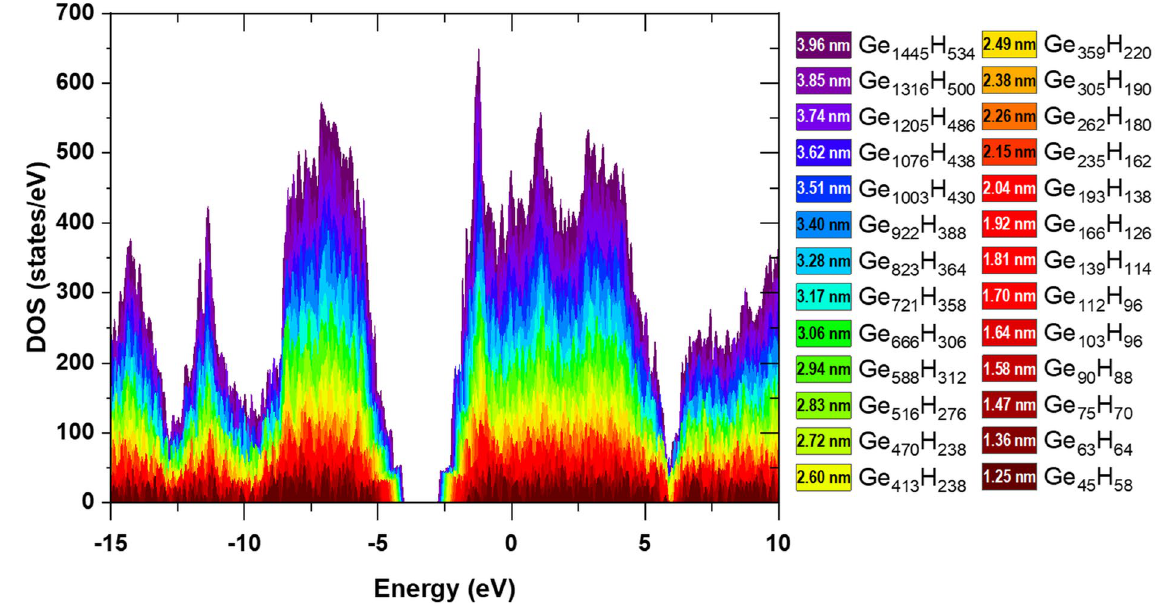
Figure 3. Cumulative DOS of Ge NCs with diameters in the 1.25–3.96 nm range (indices denote the number of Ge and H atoms).